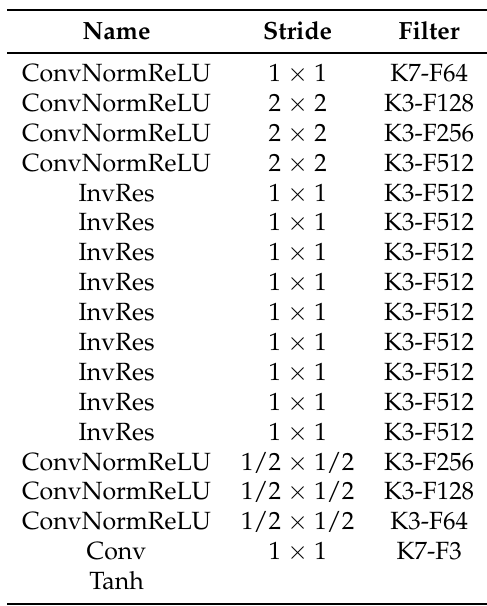
Table A4. Generator for 512 × 512